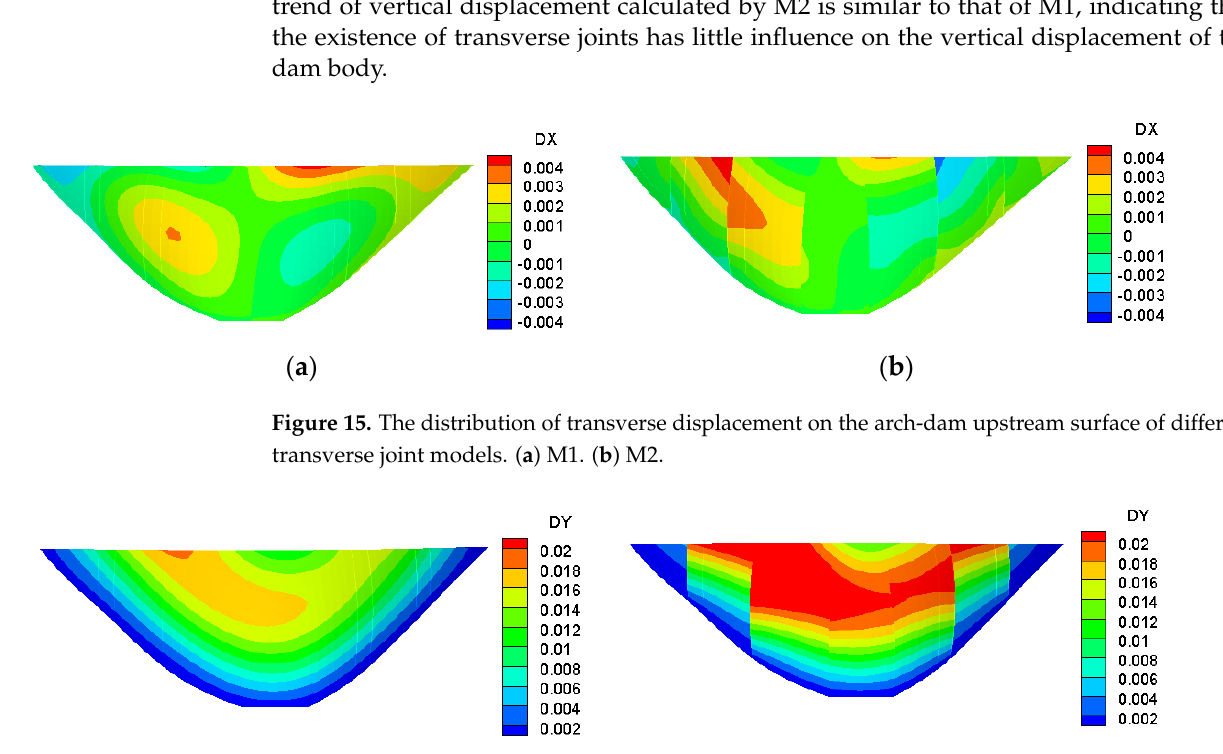
Figure 14. The computing model of arch-dam contact problem. ( a ) Layout of transverse joints. ( b ) Surface elements.